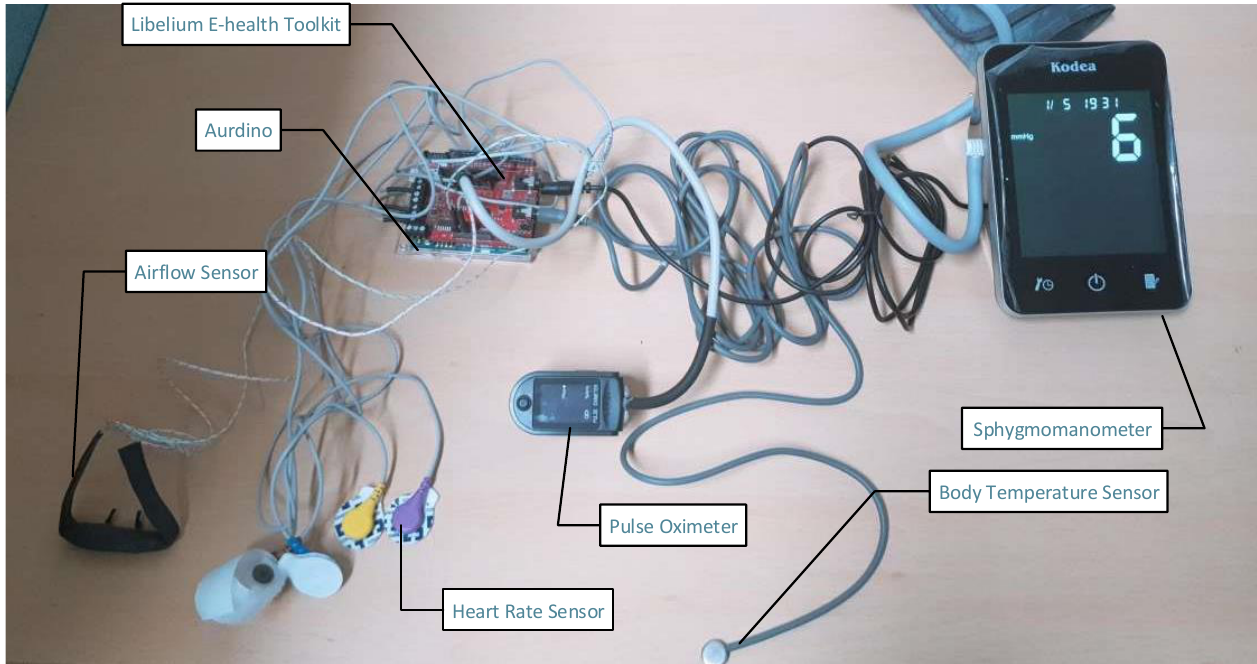
Figure 5. Experimental testbed of proposed smart